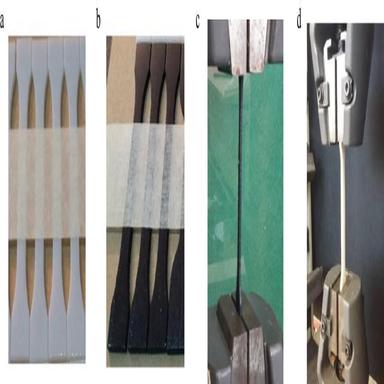
(a) VeroWhitePlus (RGD835 VW) material samples; (b) TangoBlackPlus (FLX980) material samples; and Mechanical testing of polymer samples (c) TangoBlackPlus (FLX980); (d) VeroWhitePlus (RGD835 VW).